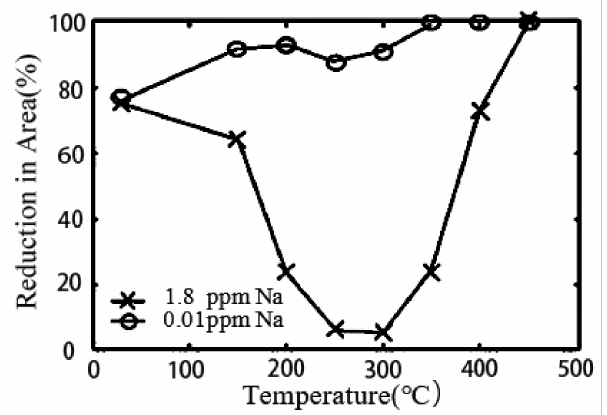
Figure 13. Variation of RA with test temperature for an Al-5Mg alloy with different contents of Na. Reprinted with permission from ref. [15]. Copyright 2001